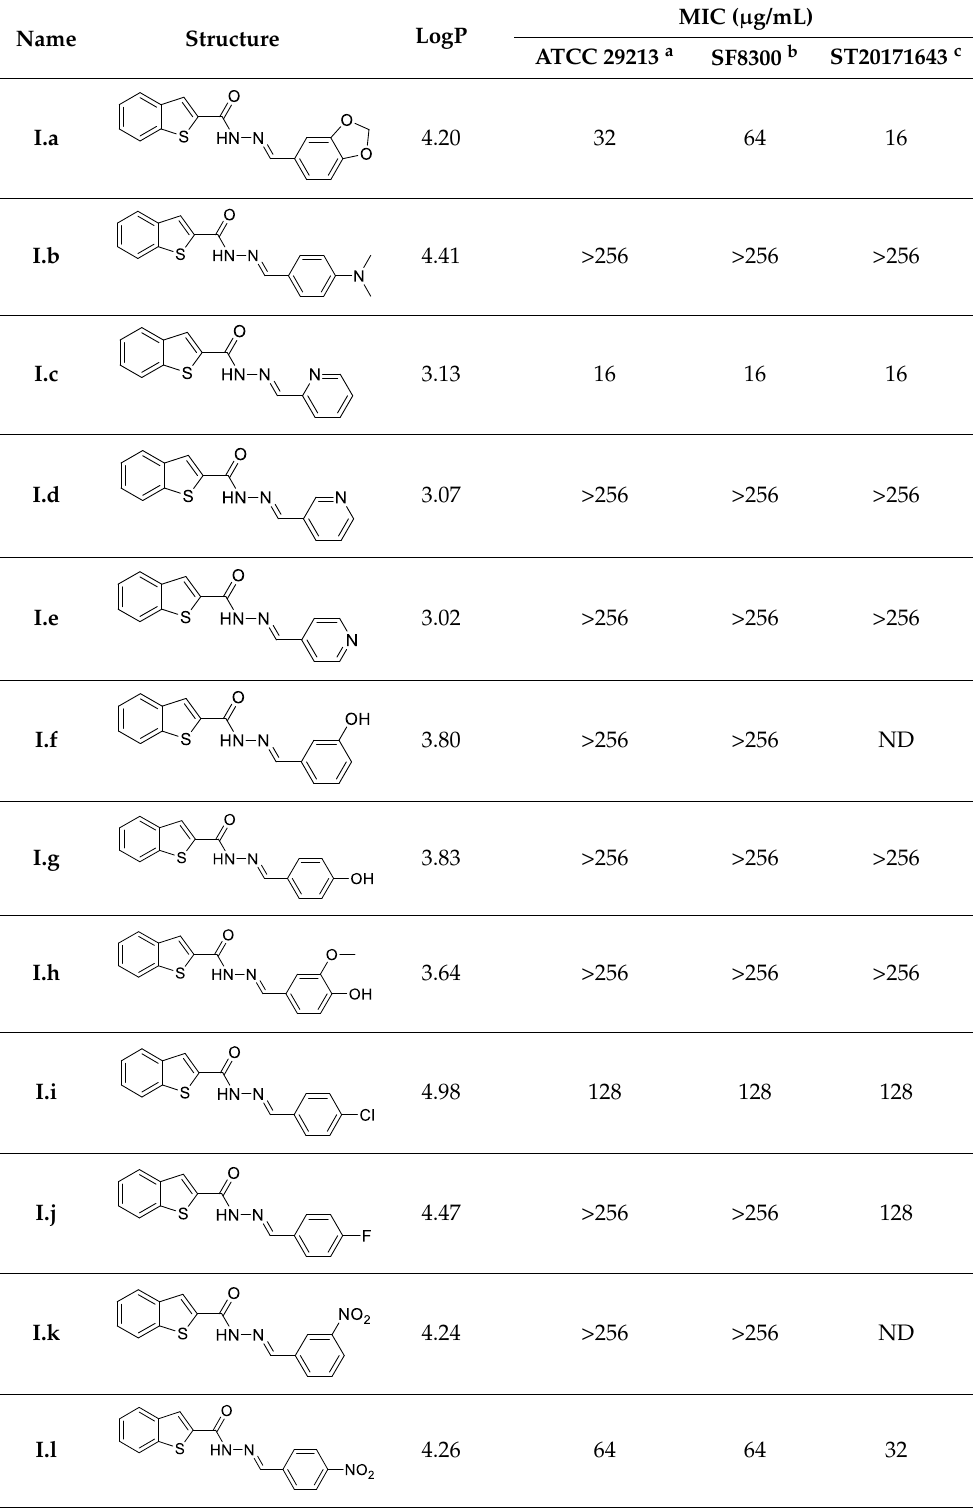
Table 1. Minimum inhibitory concentrations of set I molecules against S. aureus strains. Name